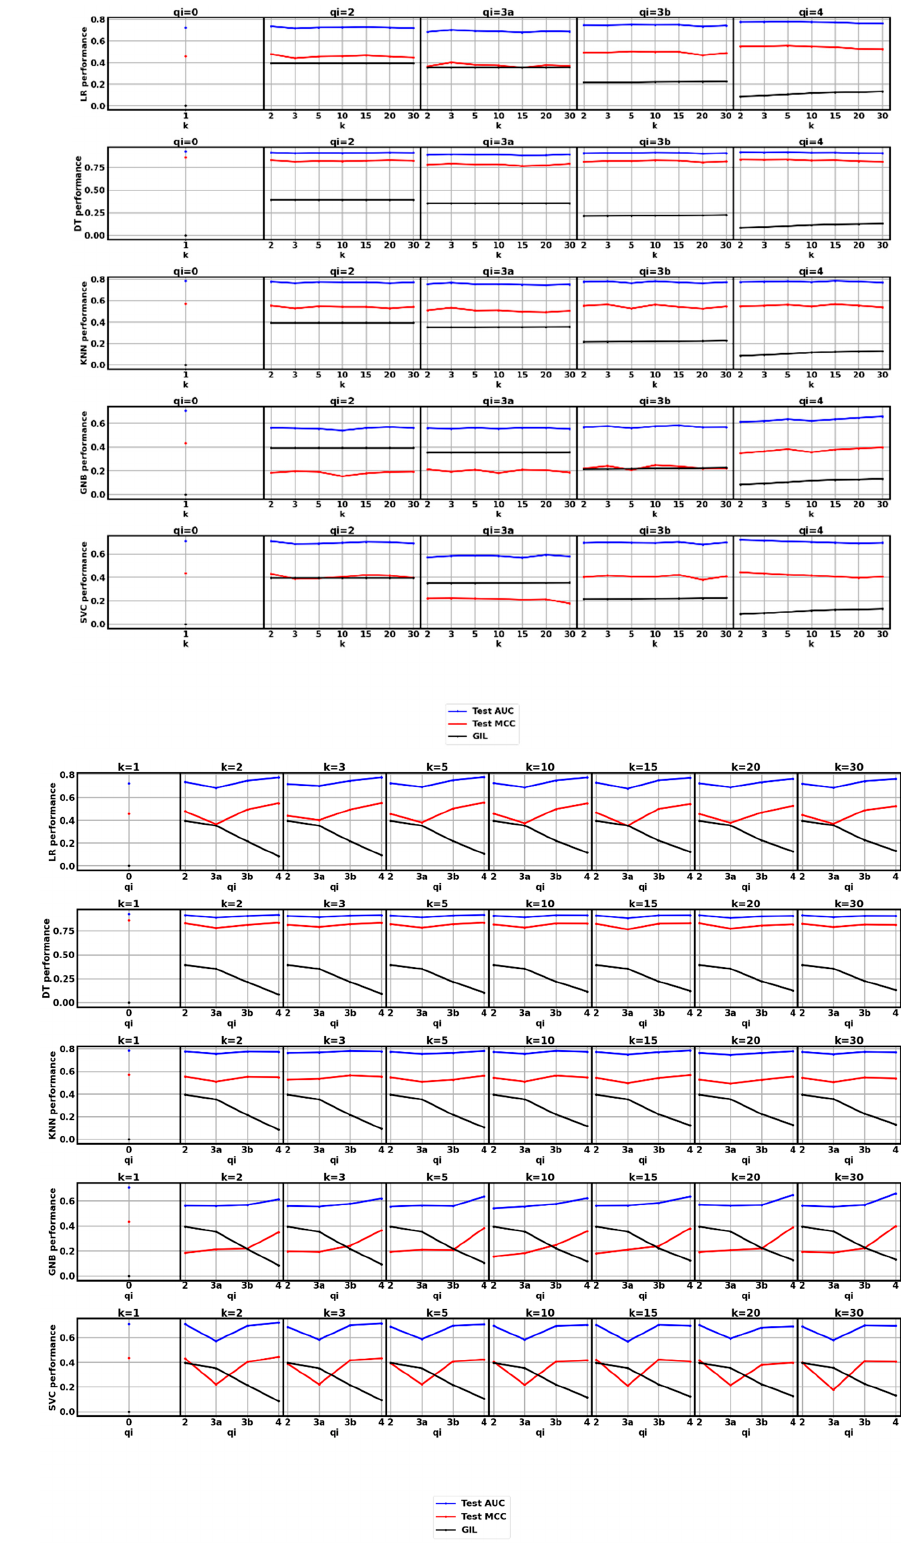
Figure 2. The prediction results of the tested machine learning models demonstrated with the AUC and MCC metrics, in juxtaposition with the GIL value. ( a ) The results of the logistic regression (LR), decision tree (DT), Gaussian naïve Bayes (GNB), k-nearest neighbors (KNN) and support vector machine (SVC) classifiers, plotted against k , for each qi value. ( b ) The results of the same models plotted against qi for each k value.